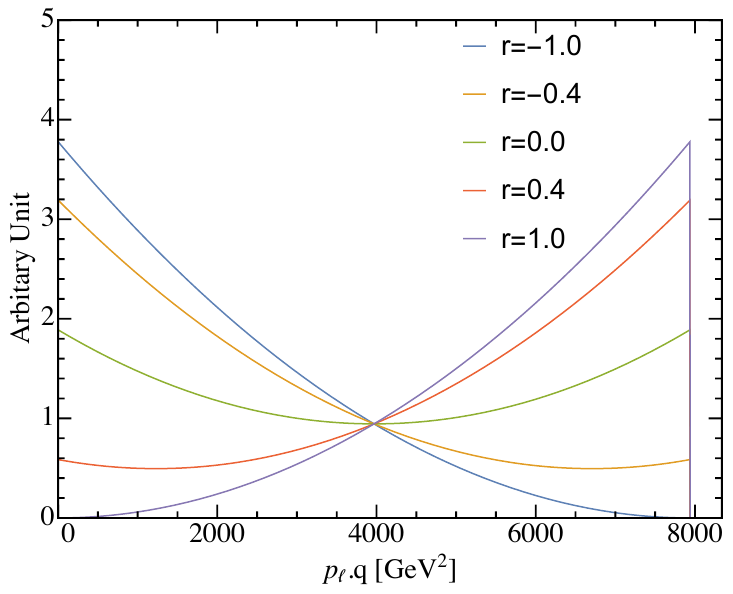
Figure 1 . The ideal H + ~ S=S . For concreteness we set m r (cid:17)